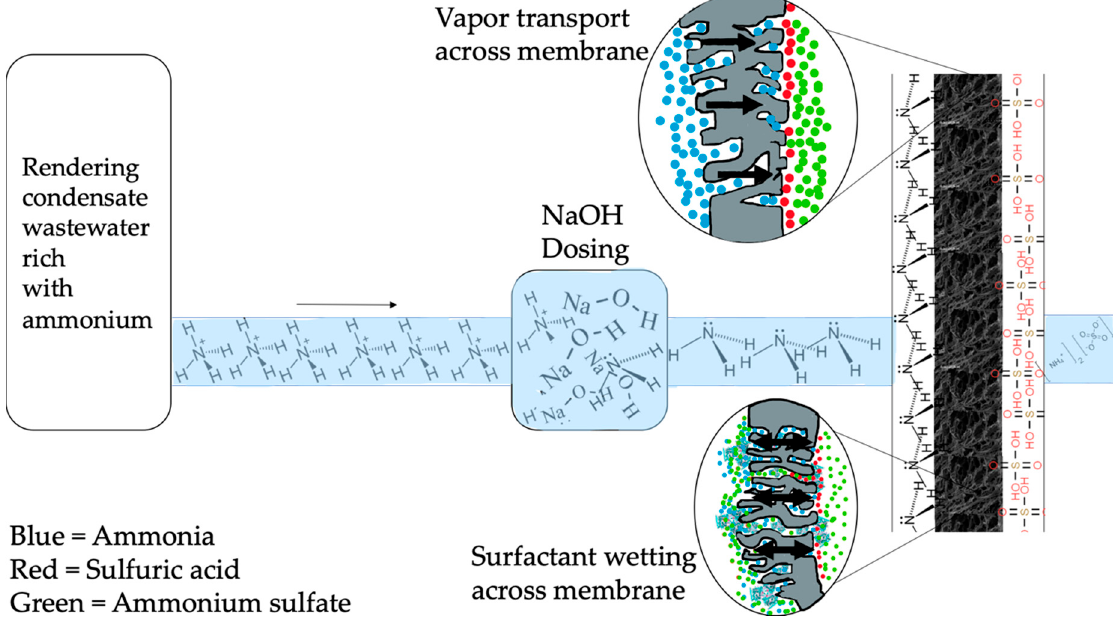
Figure 8. Molecular composition throughout membrane process.